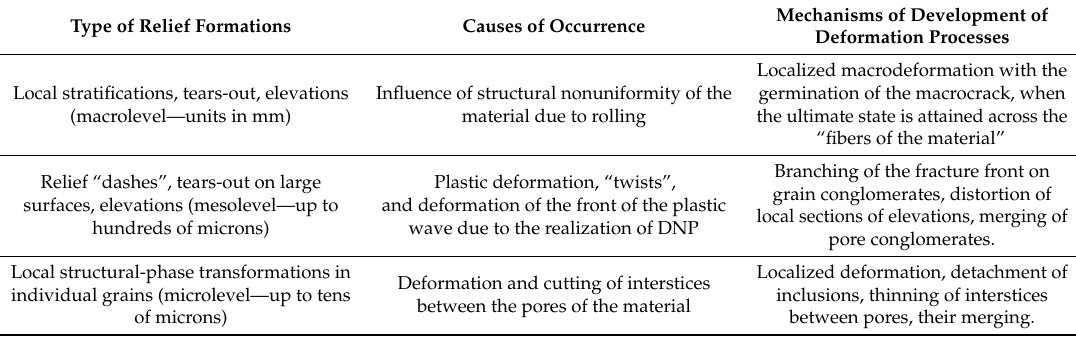
Table 3. Scale levels of deformation and fracture mechanisms of the alloy